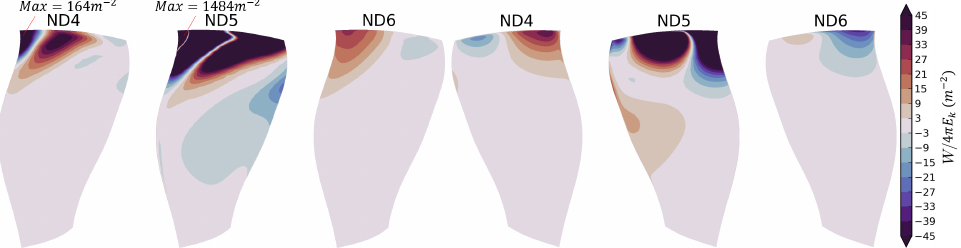
Figure 17. Local work at OP-D for Modes 2ND4 to 2ND6: ( left three blades ) suction side; ( right three blades ) pressure